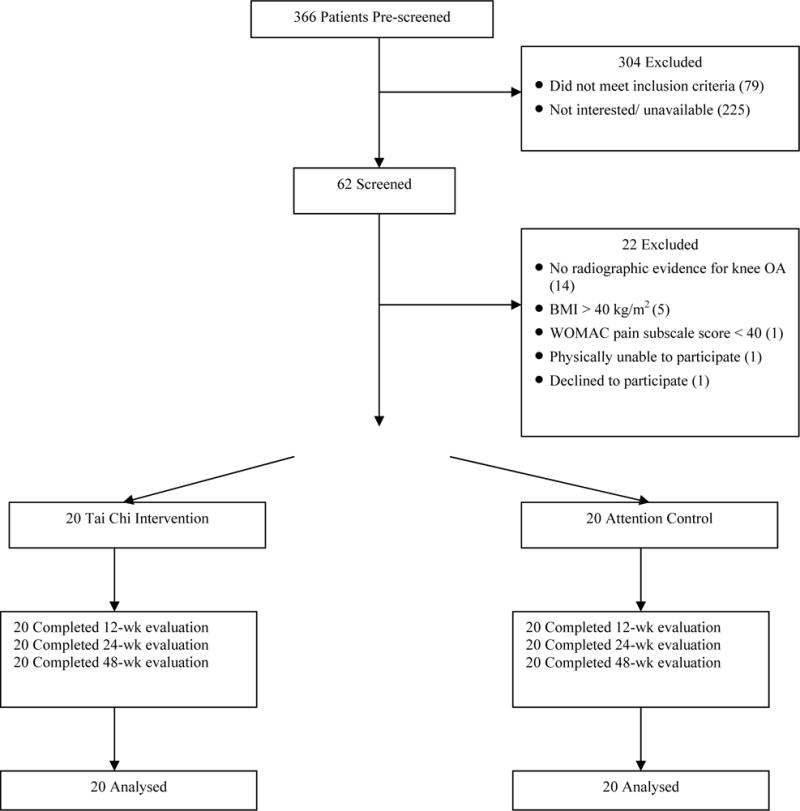
Study Flow Chart